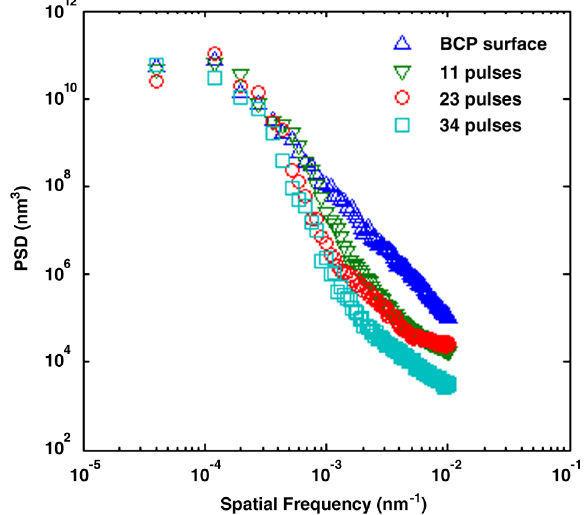
FIG. 8. PSD of AFM data corresponding to Fig.